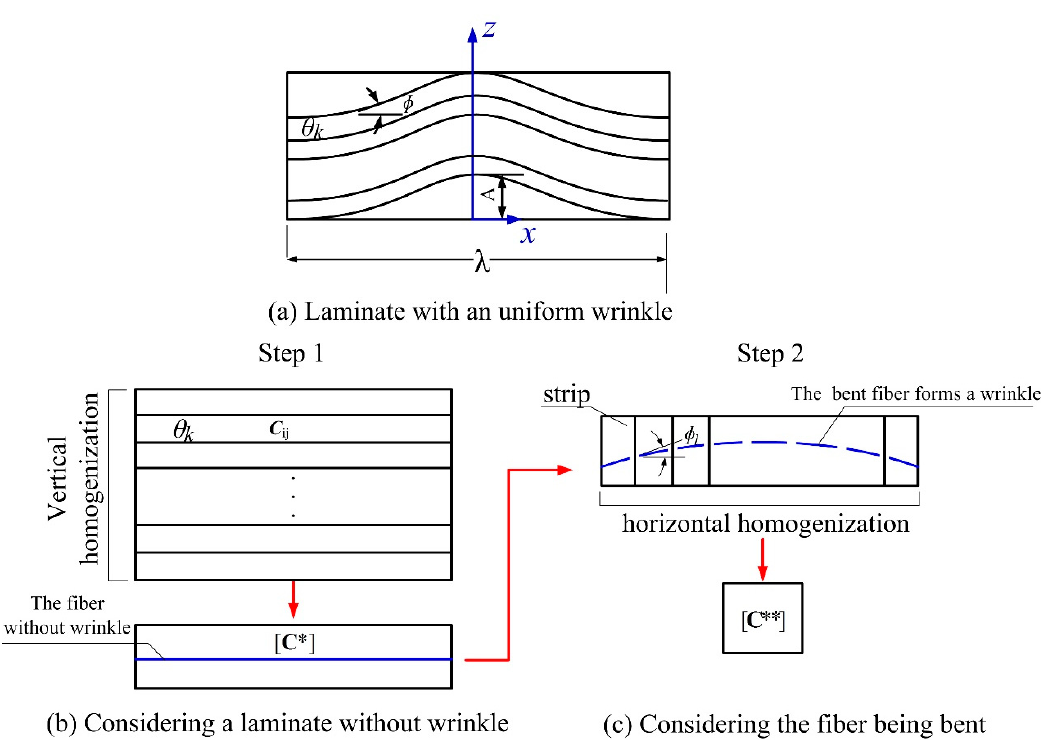
Figure 3. Two-step homogenization procedure for uniform wrinkle.